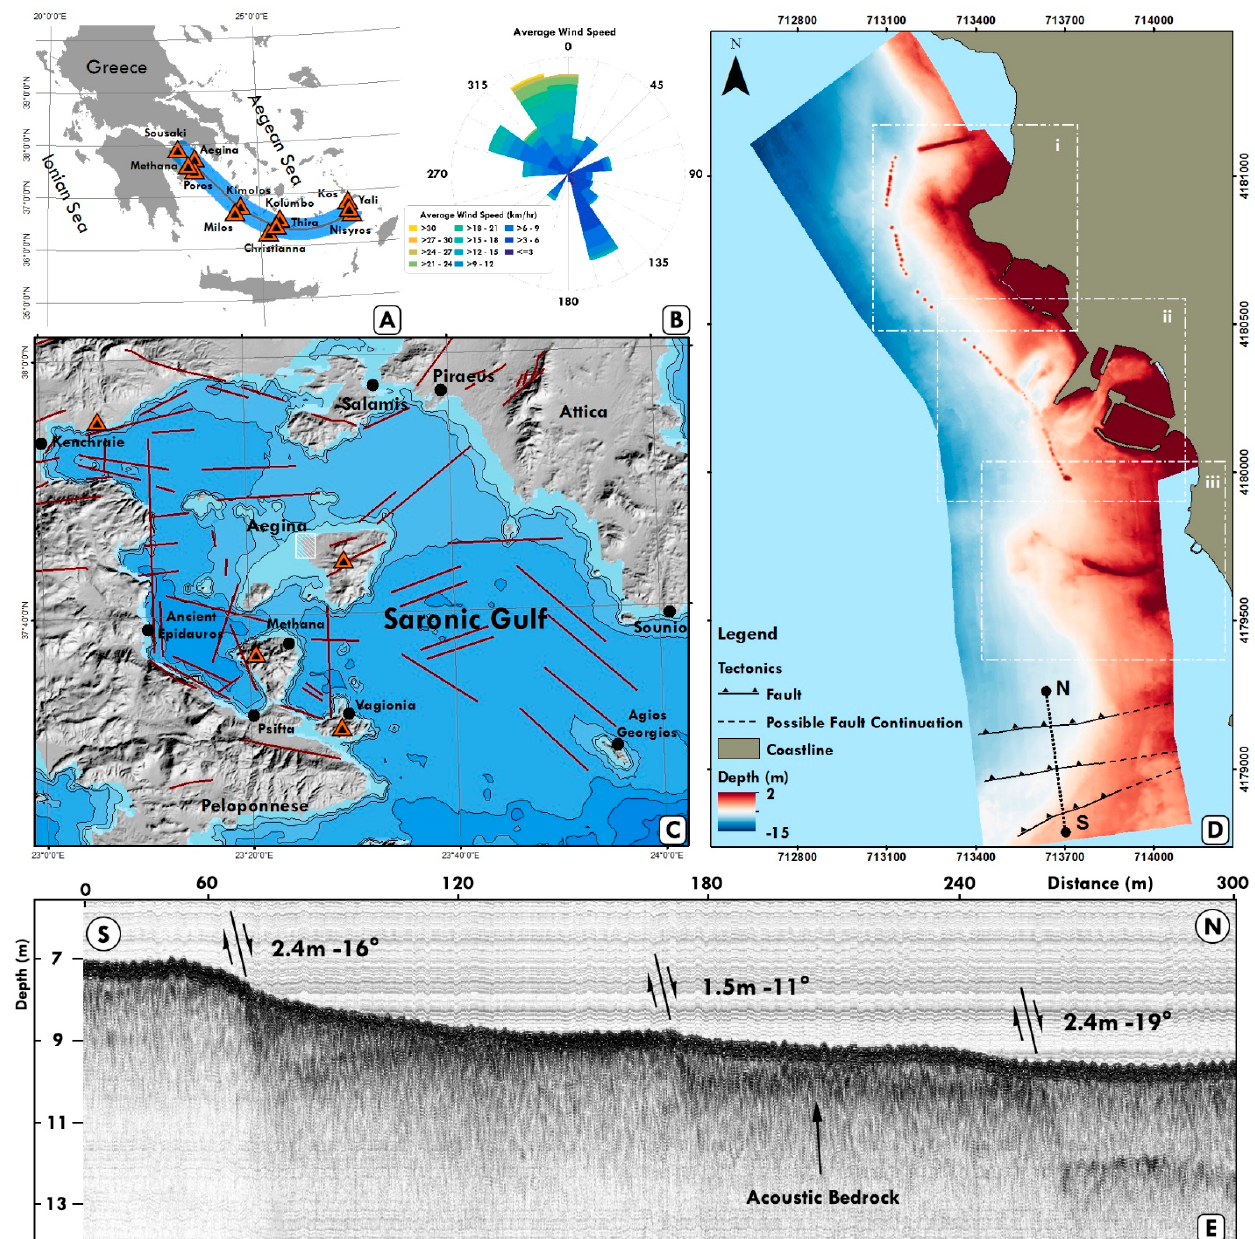
Figure 1. ( A ) Greek volcanic centers and arc, ( B ) Average wind speed of Aegina island (National Observatory Athens- Aegina weather station), ( C ) Ancient coastal sites and volcanic centers in the Saronic Gulf, main faults and survey area, ( D ) Bathymetric map of the survey area (Aegina city coastal zone), the three main areas analyzed in the results section (i, ii, iii- Sections 4.1.1–4.1.3), the main faults detected at the southern part of the area based on the ( E ) seismic profile where three normal faults are detected supporting the subsidence referred in literature.